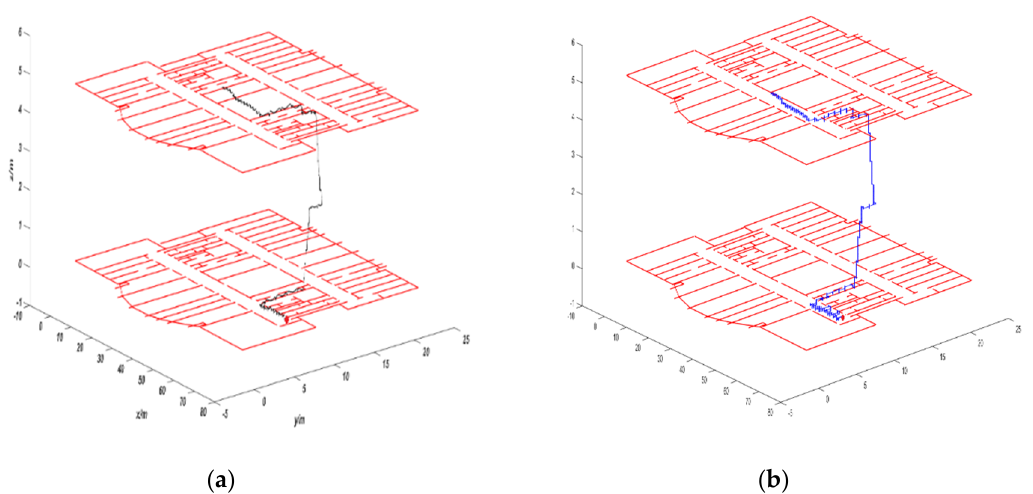
Figure 9. Comparison of trajectory: ( a ) VIO trajectory and ( b ) trajectory using CRF algorithm.